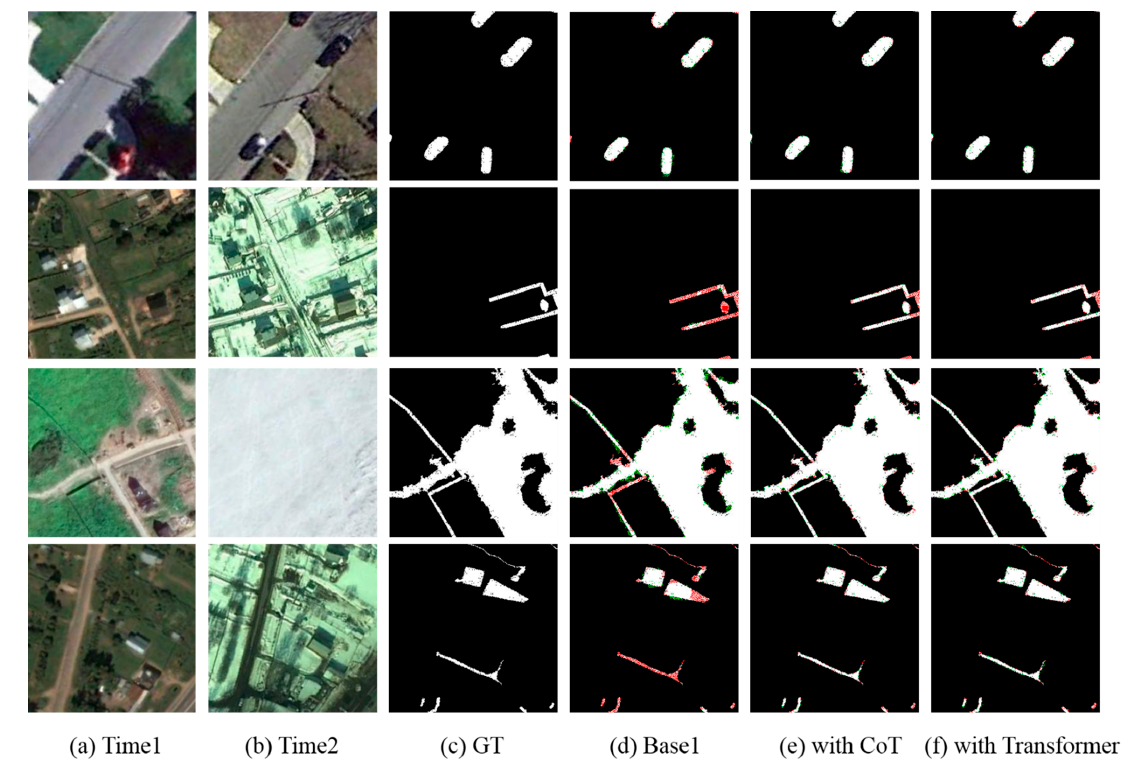
Figure 11. Ablation Base1 experimental results on the CCD dataset. ( a ) The images at time1. ( b ) The images at time2. ( c ) The ground truth. ( d ) The results of Base1. ( e ) The results of “Base1 + CoT”. ( f ) The results of “Base1 + Transformer”.